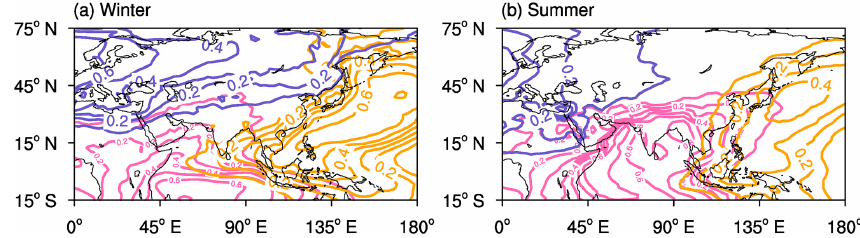
Figure 5. Distributions of the ratios of precipitation (unit: ratio of tagged precipitation over total precipitation) supplied from the NAO (slate blue), the extended northern Indian Ocean (NIO + BOB + AS, pink), and the extended north-western Pacific (NWP + SCS, orange) during (a) winter and (b) summer. Contour interval is 0.1.